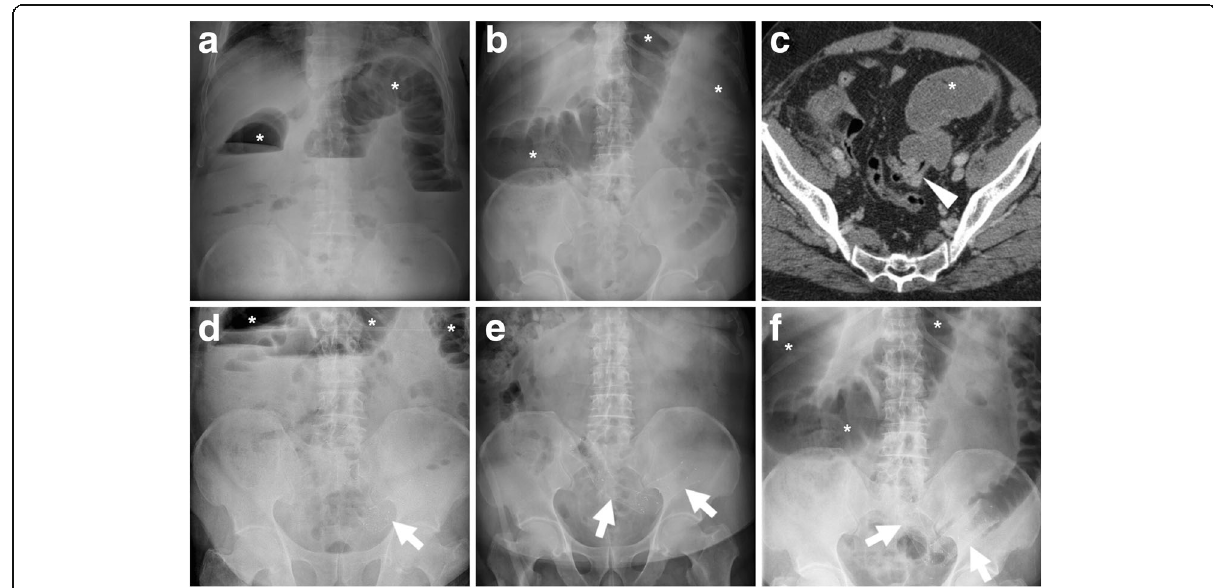
Fig. 14 Stent malpositioning causing failed relief of LBO. Initial upright ( a ) and supine ( b ) plain radiographs showed dilated colon (*) with air-fluid levels ( a ) consistent with distal mechanical obstruction. CT ( c ) and endoscopy confirmed a short “ apple-core ” stricture consistent with sigmoid CRC (arrowhead in c ). A week after the procedure, radiographic follow-up ( d - f ) showed persistently dilated bowel above two angulated SEMS (thick arrows). Immediate surgery was required to remove pT3N0